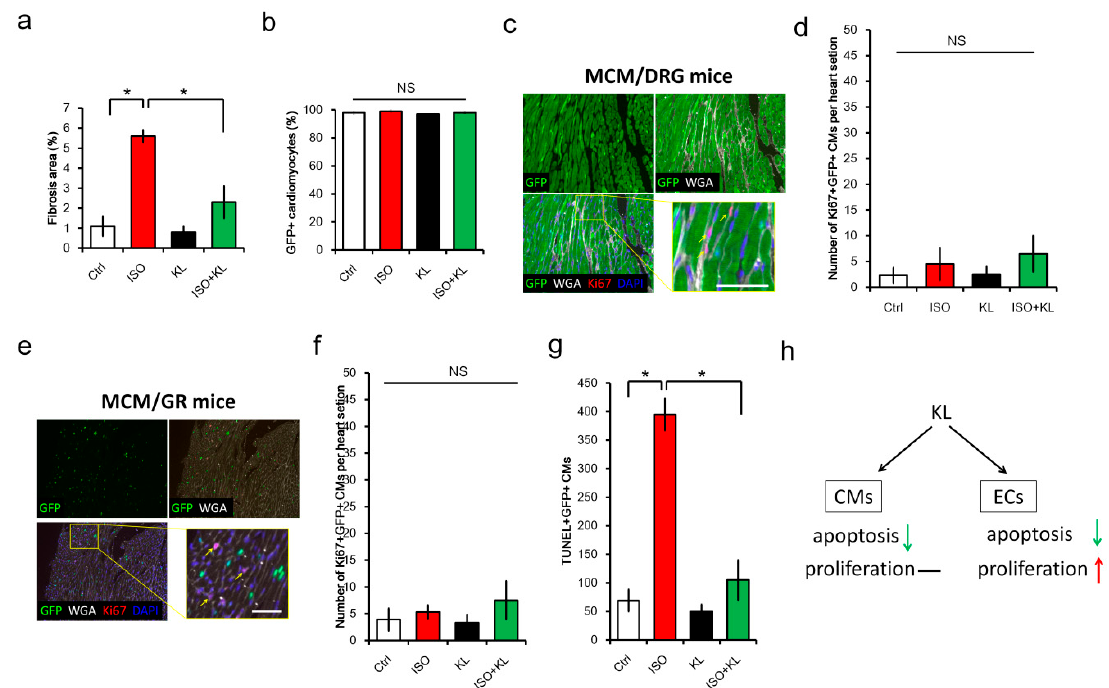
Figure 6. KL attenuated isoproterenol-induced cardiac fibrosis and cardiomyocyte apoptosis without altering cardiomyocyte renewal in adult mice. ( a ) MCM/DRG mice ( n = 5 in each group) with isoproterenol-induced cardiac injury (100 mg/kg/day for 5 days) were injected with saline or KL recombinant protein. Cardiac fibrosis was analyzed on day 7 post-cardiac injury. ( b ) The percentage of GFP+ cardiomyocytes among cardiac troponin T (cTnT)+ cells was quantified using immunohistochemistry staining with a GFP antibody. ( c ) Localization of Ki67-positive non-myocardial cells in the heart of isoproterenol-treated MCM/DRG mice. Bars represent 50 μ m. ( d ) The number of Ki67+GFP+ cardiomyocytes within the myocardium. ( e ) MCM/GR mice ( n = 5 in each group) with isoproterenol-induced cardiac injury (100 mg/kg/day for 5 days) were injected with saline or KL recombinant protein. Localization of Ki67-positive non-myocardial cells in the heart from ISO-treated MCM/GR mice. Bars represent 50 μ m. ( f ) The number of Ki67+GFP+ cardiomyocytes within the myocardium. ( g ) The number of TUNEL+GFP+ cardiomyocytes within the myocardium. ( h ) KL mediated its cardioprotective effect by inhibiting apoptosis and promoting the proliferation of endothelial cells following cardiac injury. No evident cardiomyocyte proliferation was found following isoproterenol-induced cardiac injury in the presence or absence of exogenous KL. NS denotes no significant differences, and * denotes p < 0.05.